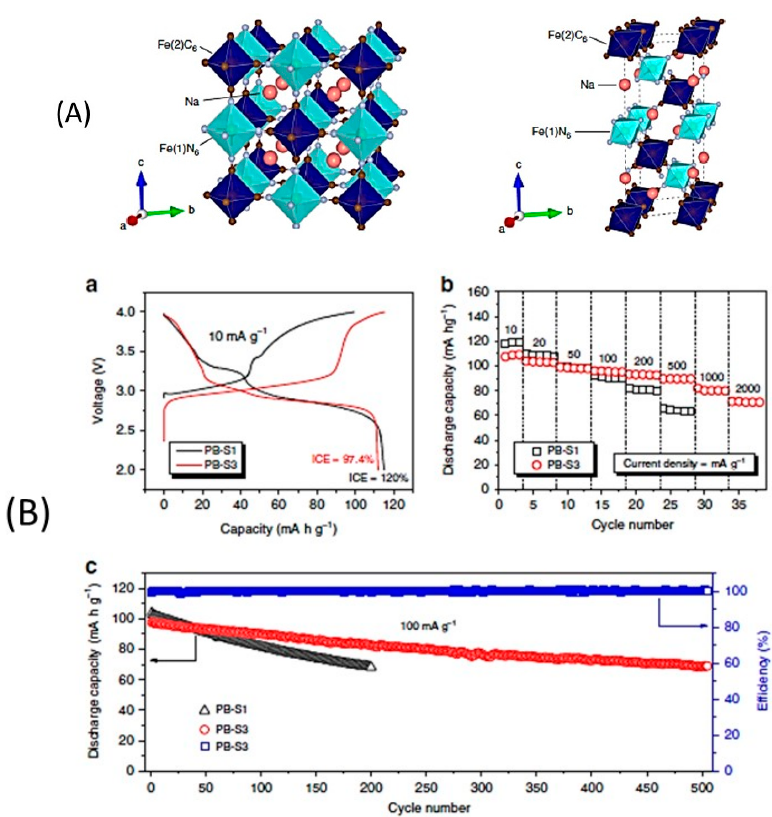
Figure 7. ( A ) Schematic structure of Na 2-x FeFe(CN) 6 (Na in red, C in brown, N in grey, Fe1 and Fe2 in cyan and blue, respectively). ( B ) The electrochemical properties. ( a ) initial charge–discharge curves, ( b ) rate and ( c ) cycling performance. Reproduced with permission from [167]. Copyright 2020 Springer. Ref.